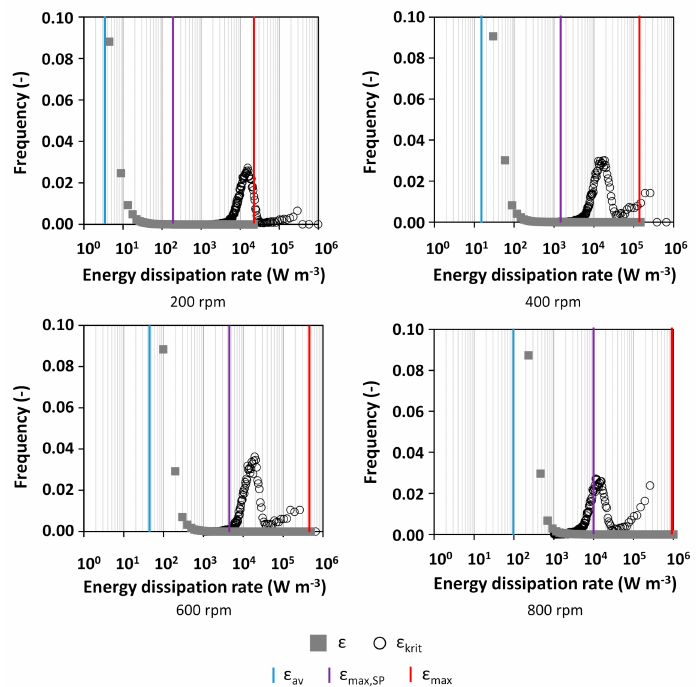
Figure 7. Critical energy dissipation rate ε krit distributions (black circles) calculated from the cell size distributions in the SIS compared to the energy dissipation rate distribution in the reactor system (grey squares) obtained from CFD data. The averaged energy dissipation rates from CFD simulations are indicated in blue, their maxima in red, maximum energy dissipation rates calculated from slice plots are indicated in purple.